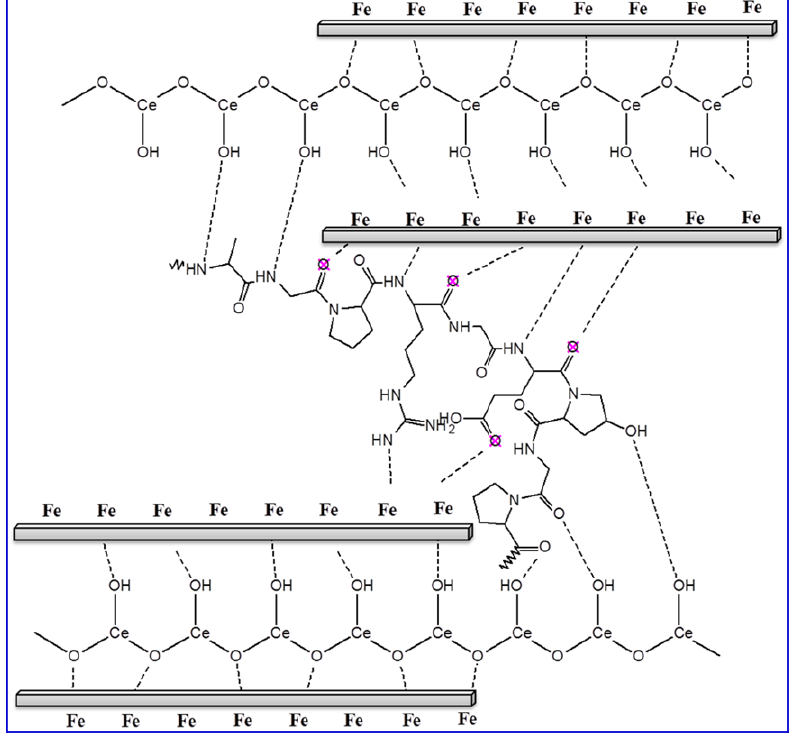
Figure 10. Schematic representation for the CeO 2 @gelatin molecule adsorption on the X60 ‐ steel substrate in HCl solution.